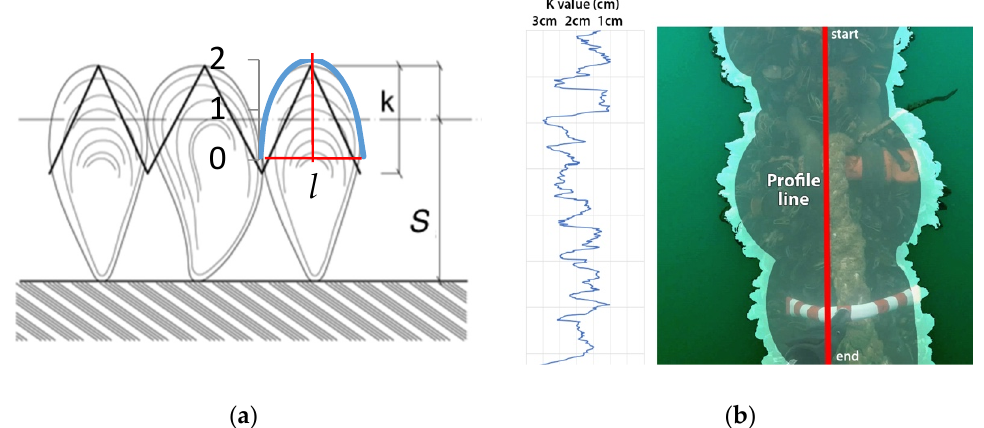
Figure 2. ( a ) Definition of the roughness for a given size of the shell S (numbers in cm); ( b ) typical extraction of the roughness from image processing.